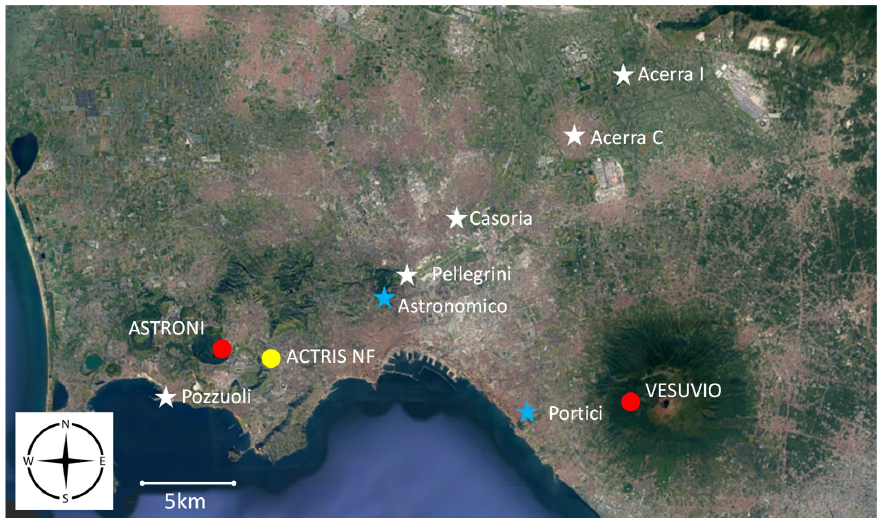
Figure 1. Map of the city of Naples with the location of the Actris National Facility (Actris NF), the Astroni Natural WWF Reserve (Astroni) and the National Park of Vesuvius (Vesuvio). Stars refer to the 7 sampling sites of the ARPAC air quality monitoring network equipped with instruments for continuous measurements of PM concentration.